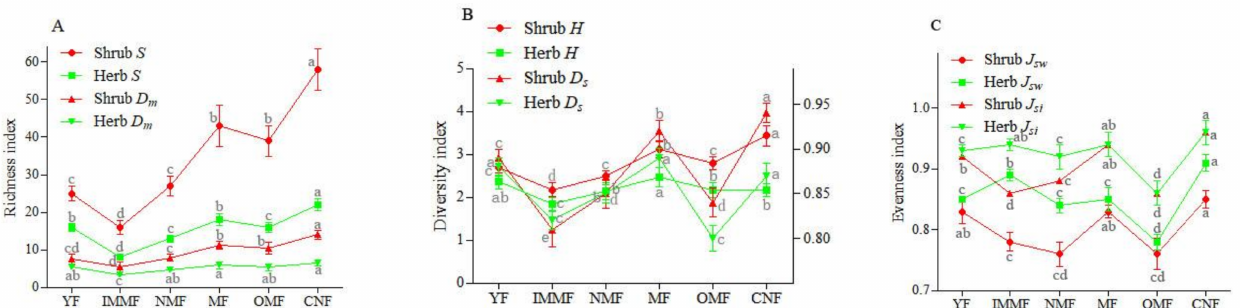
Figure 3. Diversity indices of shrub and grass calculated from plant investigation. ( A ) Richness index ( S ) and Margalef index ( D m ), ( B ) Shannon diversity index ( H ) and Simpson index ( D s ), ( C ) McIntosh evenness index ( J si ) and Shannon evenness index ( J sw ). p -values within each column were determined by ANOVA. Different lowercase letters between different stand ages in the same soil layer indicate significant differences as determined by Tukey’s HSD test ( α =